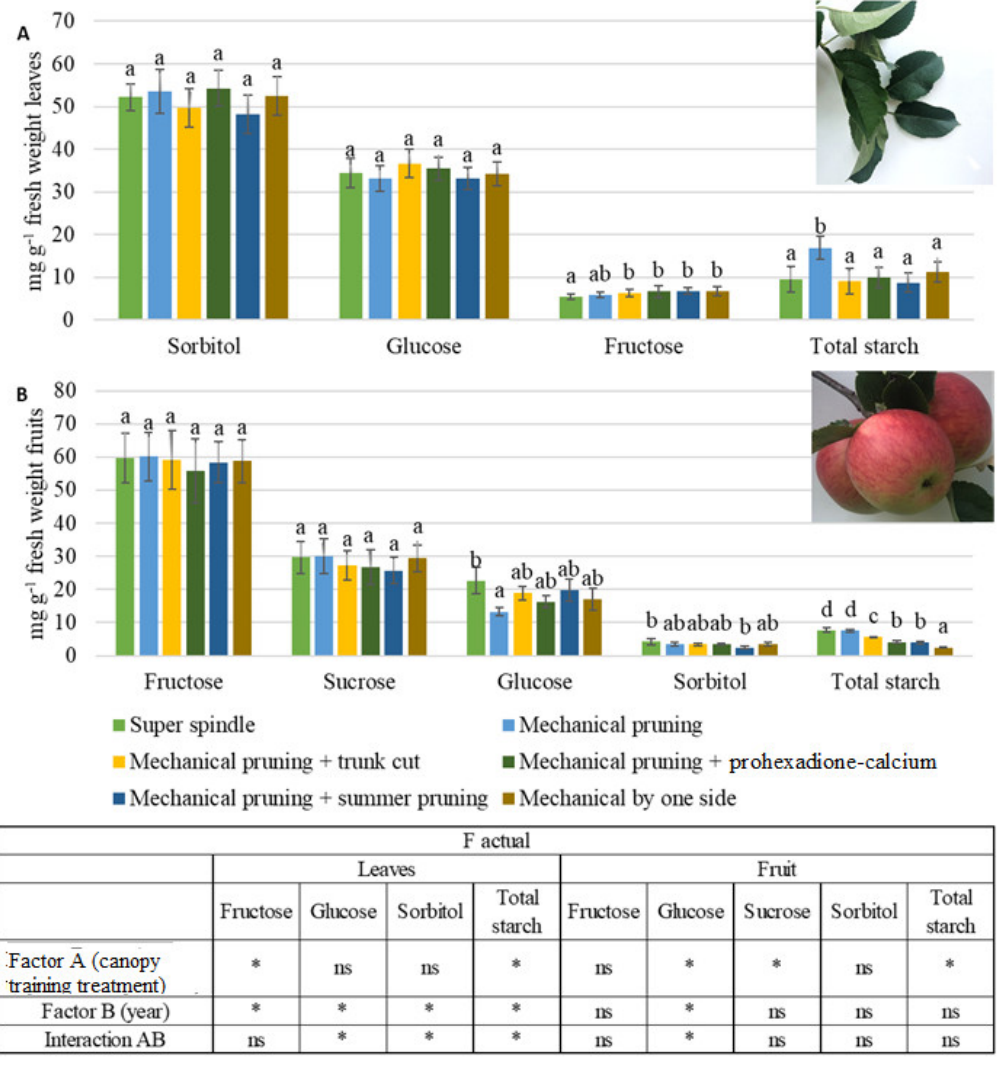
Figure 4. The effect of canopy training treatments on carbohydrates in cv. Rubin leaves ( A ) and fruits ( B ) at BBCH 87–88. The mean value of three years ( n = 3 × 3 = 9) ± standard deviation is presented. The data were processed using a two-way analysis of variance (ANOVA), the Tukey (HSD) test at the confidence level p = 0.05. The different letters in blocks indicate significant differences in treatment, LSD–Fisher’s protected least: * p < 0.05 shows significant differences, ns—no significant differences.